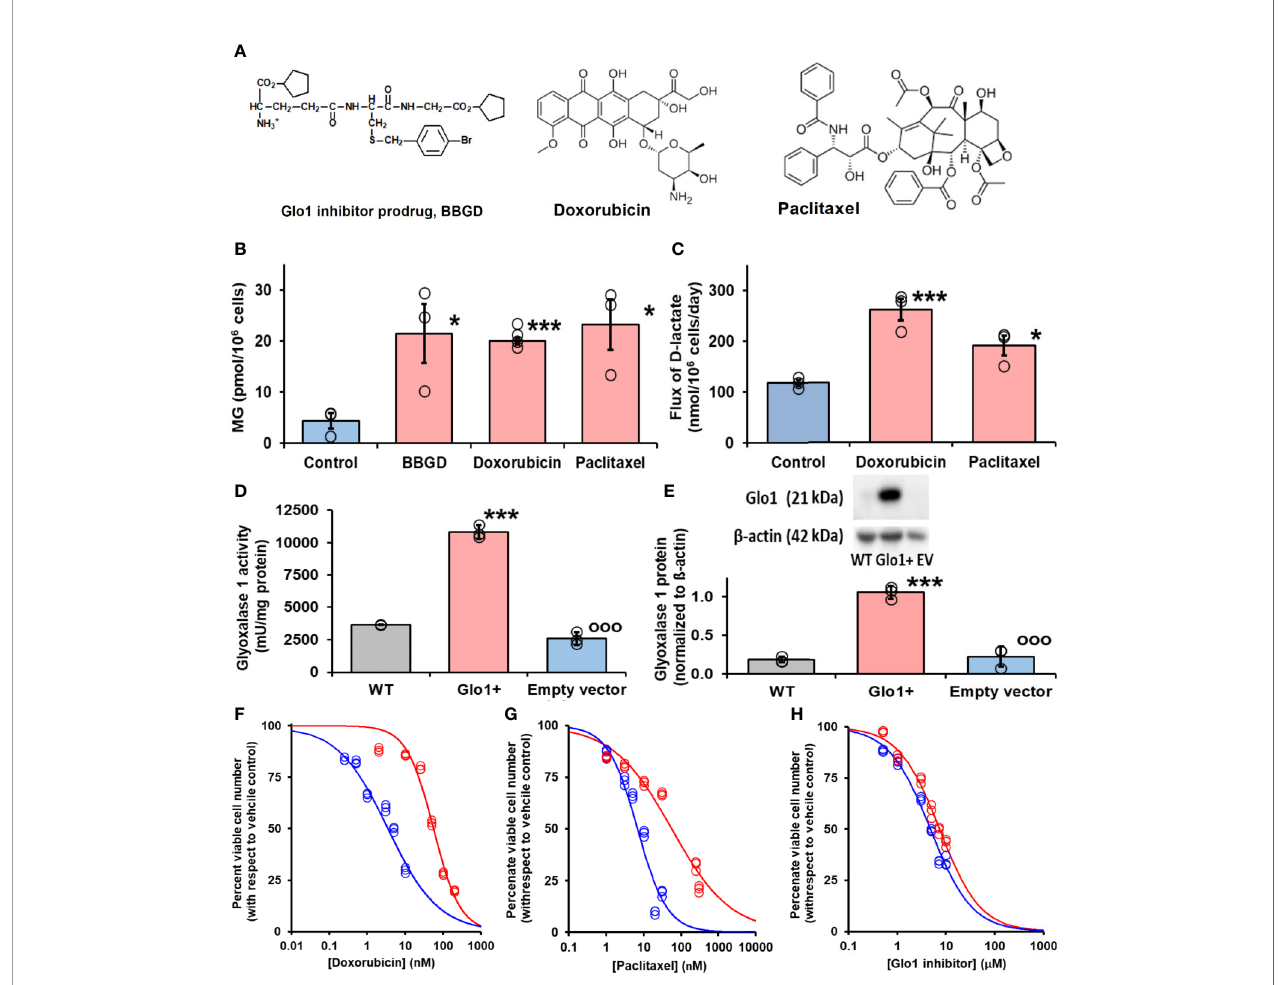
FIGURE 3 | Glyoxalase 1 inhibitor prodrug, doxorubicin and paclitaxel increase cellular concentration of methylglyoxal to virucidal levels. (A) Molecular structures of drugs. Glyoxalase 1 inhibitor prodrug, S-p-bromobenzylglutathione cyclopentyl diester (BBGD). Delivers competitive Glo1 inhibitor, S-p-bromobenzylglutathione, K i = 160 nM, into cells (Allen et al., 1993; Thornalley et al., 1996). Doxorubicin – topoisomerase inhibitor.(Tewey et al., 1984) Paclitaxel – stabilizer of microtubule assembly (Schiff et al., 1979). (B, C) Increase in cellular methylglyoxal (MG) in HEK293 cells and fl ux of formation of D-lactate (surrogate for fl ux of MG), respectively, incubated in vitro with and without investigational agent and drugs indicated. For assay of MG, cells were incubated with and without treatment for 3 h and for fl ux of D-lactate incubated for 24 h. Data are mean ± SEM (n = 3 except n = 4 for MG estimation with Doxorubicin; individual data points are shown). Drug concentrations: BBGD, 7.4 µM; doxorubicin, 6.0 nM, paclitaxel, 21 nM. Signi fi cance: b. P<0.02 and c. P<0.01 ( one-way ANOVA ) and * and ***, P<0.05 and P<0.001 with respect to control ( t-test ). (D, E) Activity and protein of Glo1, respectively, in HEK293 cells: wild-type (WT) and cells stably transfected to overexpress Glo1 (Glo1+) and empty vector (EV). Glo1 activity and protein were increased four- to fi vefold. This was maintained for > 10 passages. (F – H) Effect of Glo1 expression on anti-proliferative activity. Key: blue – empty vector, red – Glo1 overexpression. HEK293 cells were incubated with and without treatment for 48 h. Data (six drug concentrations in triplicate) were fi tted by nonlinear regression to the dose-response equation, V = 100 x GC 50n /(GC 50n + [Drug] n ), solving for GC 50 and, n (logistic regression coef fi cient). (F) Doxorubicin: empty vector, GC 50 = 3.54 ± 0.28 nM, n = 0.71 ± 0.05; Glo1+, GC 50 = 55.9 ± 3.4 nM, n = 1.24 ± 0.10 (16-fold resistance). (G) Paclitaxel: empty vector, GC 50 = 6.8 ± 1.0 nM, n = 1.07 ± 0.17; and Glo1+, GC 50 = 56.4 ± 7.2 nM, n = 0.55 ± 0.04 (8-fold resistance). (H) BBGD: GC 50 = 4.78 ± 0.18 µM, n = 1.02 ± 0.05; and Glo1+, GC 50 = 7.37 ± 0.30 µM, n = 1.04 ± 0.06 (twofold